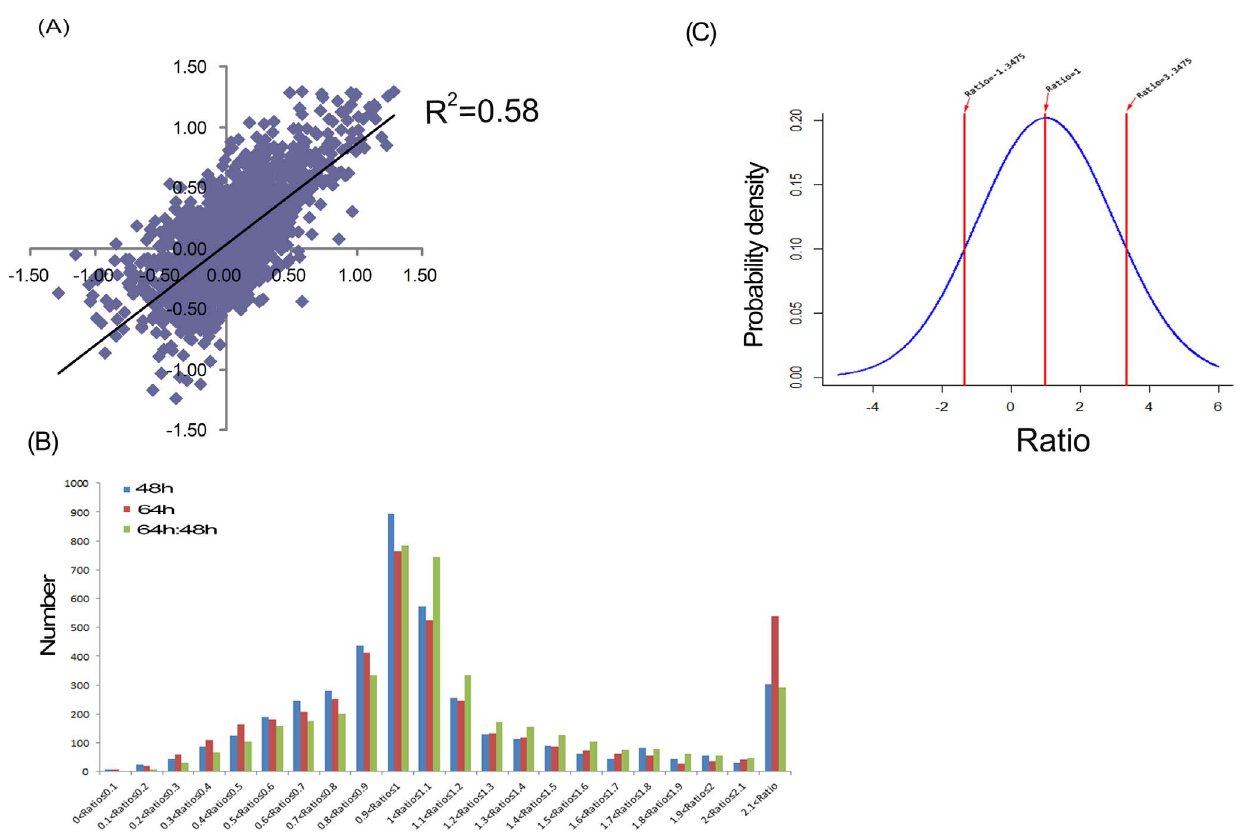
Figure 3. Results of the iTRAQ ratios analysis. (A) A scatter plot showing the correlation between the log 10 infection/mock ratios at 48 hpi and 64 hpi for the 4,112 reliably quantified proteins in the iTRAQ experiment. Linear regression analysis shows that correlation ( R 2 ) was 0.58, with a p- value less than 0.05. (B) Histograms showing the distribution of protein ratios identified at 48 and 64 hpi. (C) The distribution range of differentially expressed proteins identified at 48 hpi. iTRAQ ratios higher than 3.3475 (p=0.975) or lower than 2 1.3475 (p=0.025) were defined as statistically significant.